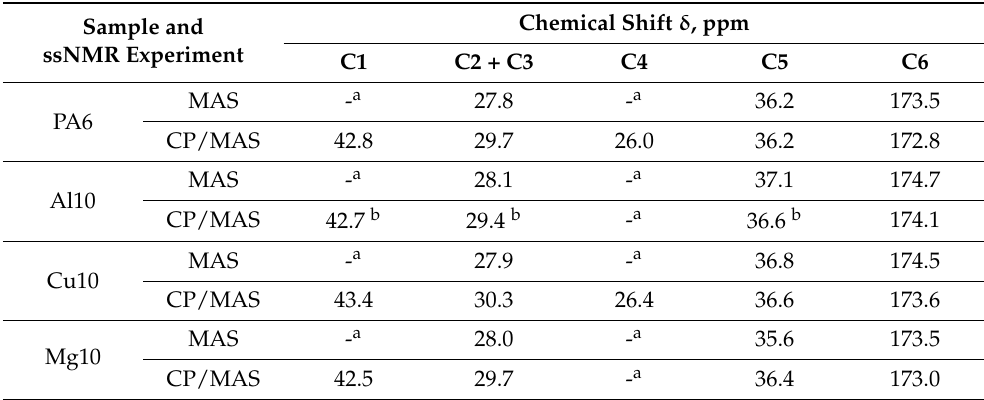
Table 2. 13 C MAS and 13 C CP/MAS chemical shifts in C nuclei obtained from MP samples. The average error of the chemical shift determination is ± 0.2